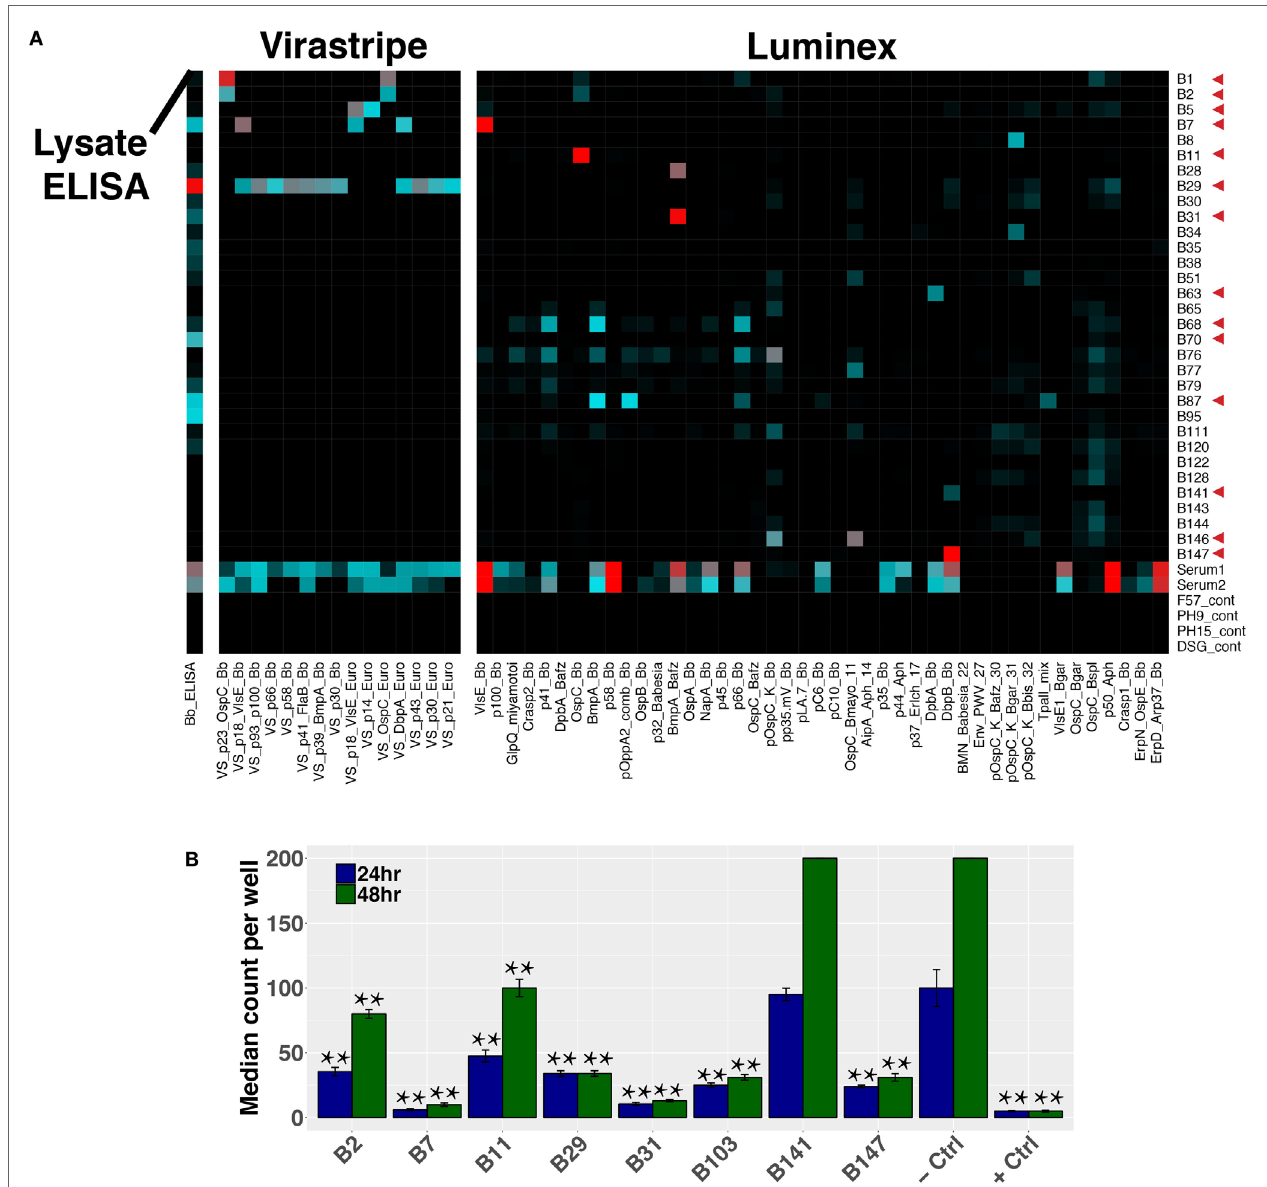
FigUre 7 | Plasmablast-derived recombinant monoclonal antibodies (rmAbs) from both acute and persistent B cell clones bind Bb -specific antigens and inhibit growth in vitro . Sequence-derived antibodies representative of the identified clonal families were synthesized, cloned, and recombinantly expressed. Recombinant expression enabled characterization of the rmAb binding targets with an in-house ELISA and multiplex bead-based assay, a commercial strip-blot assay, and in in vitro Bb growth assays. (a) Custom Luminex assay containing whole proteins and peptides derived from Bb and related species, sonicated Bb B31 lysate ELISA, and Virastripe strip-blot assay. Red arrows indicate successful ELISA validation of rmAb binding. (B) rmAbs were added to Bb cultures to assess their ability to inhibit Bb growth in vitro . The negative control was an rmAb specific for Influenza hemagglutinin, and the positive control was a conventional murine mAb specific for Bb OspA (clone CB10). P values were determined by one-way ANOVA with Tukey’s post hoc test relative to negative control, ** P <